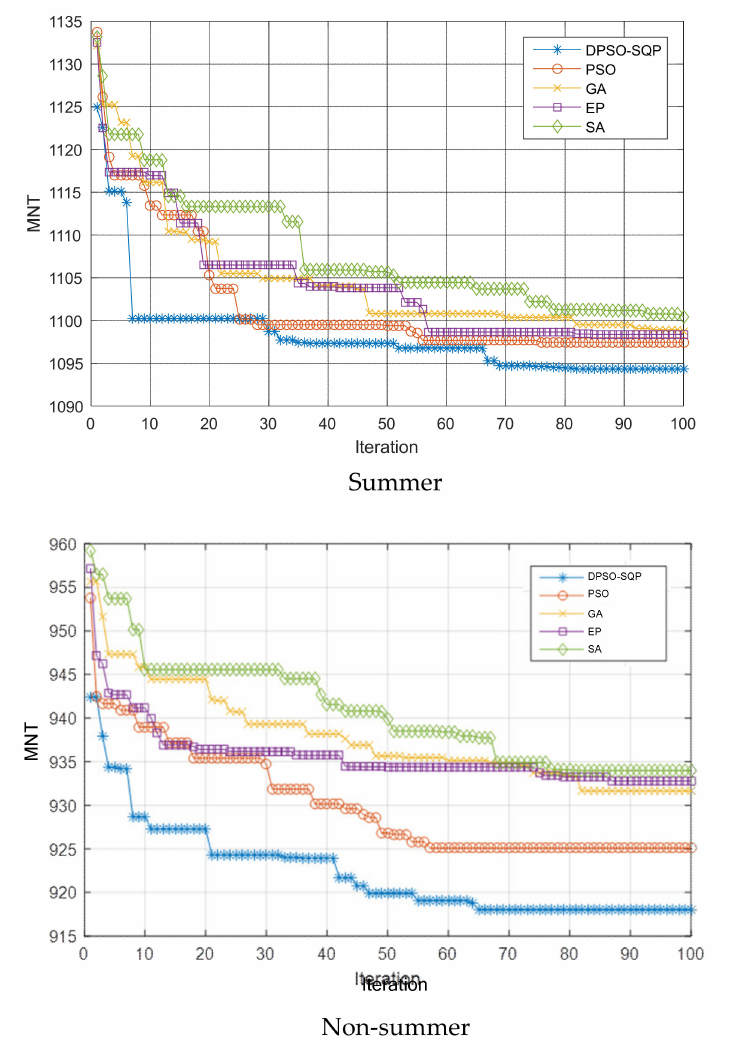
Figure 6. Convergent characteristics of all cases. Table 6. Comparison of the best values of different